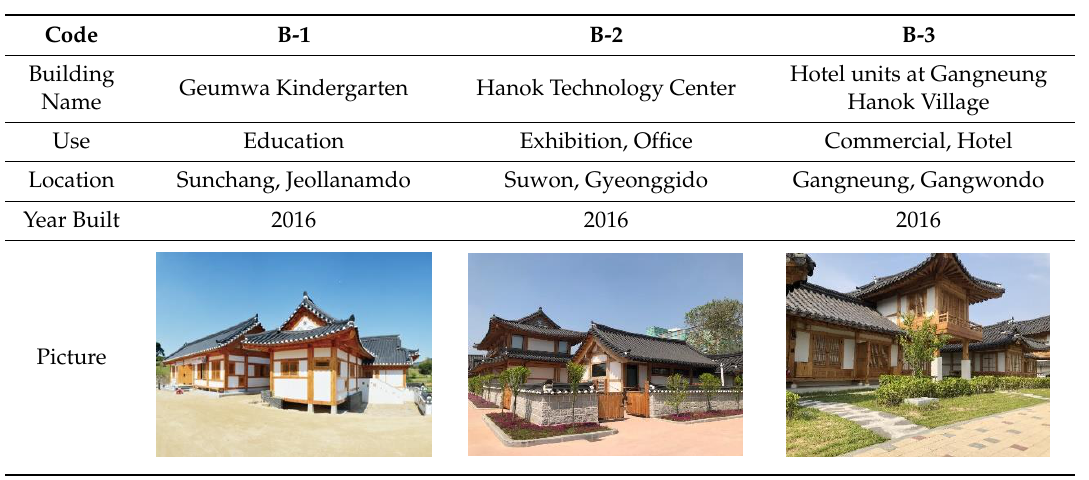
Table 3. Public Hanok facilities in Type B.